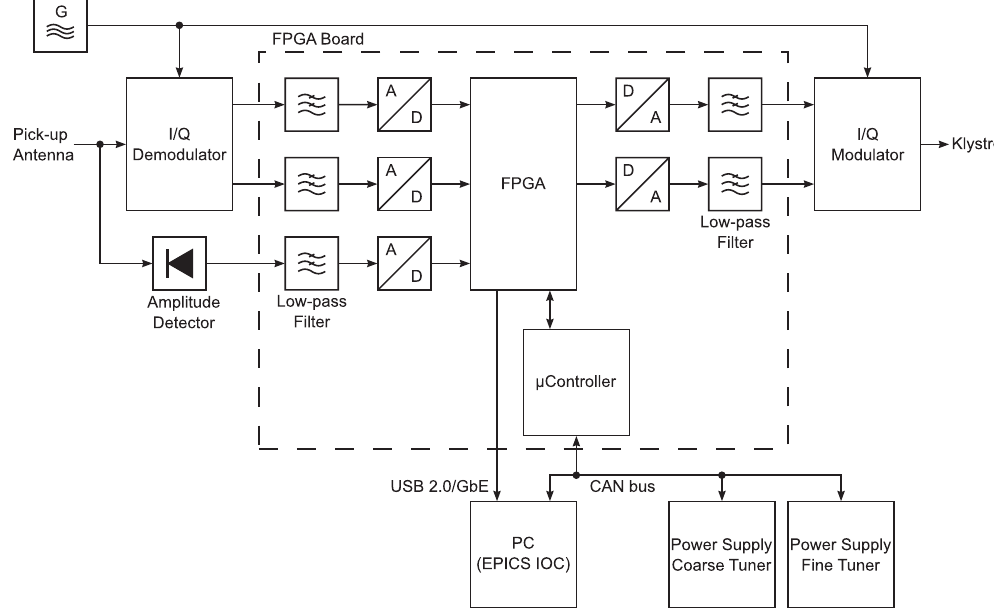
FIG. 1. Overview of the hardware components of one channel of the rf control